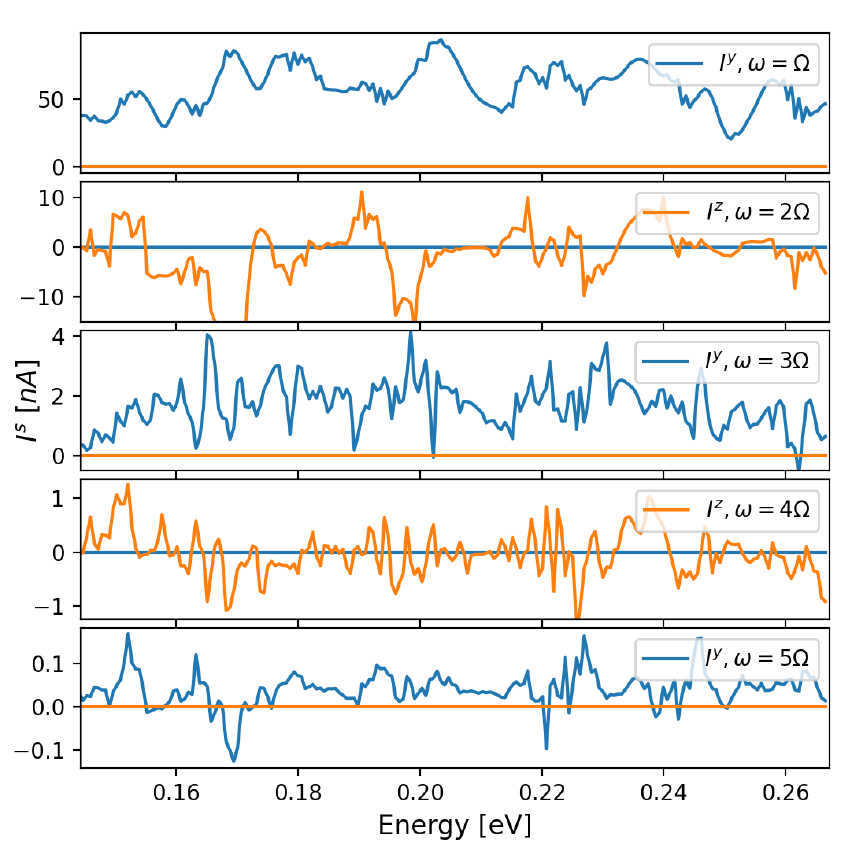
Figure 11: Higher harmonics of the induced spin currents in y (blue) and z (orange) direction in the presence of a time dependent Rashba SOI ( α ( t ) = k currents are plotted as a function of the Fermi energy for k the system size in the x-direction. The frequency is chosen such that Ω τ ≈ 1, where τ is the time of